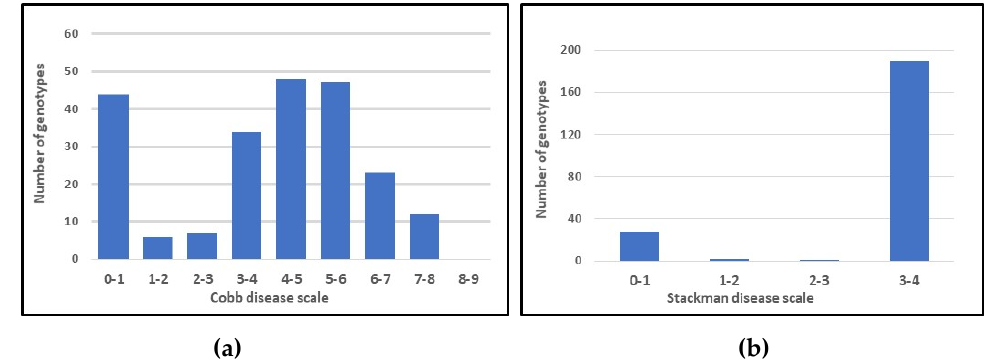
Figure 1. Frequency distribution of adult plant resistance (a) and seedling resistance (b) to powdery mildew in a collection of 221 tetraploid wheats.